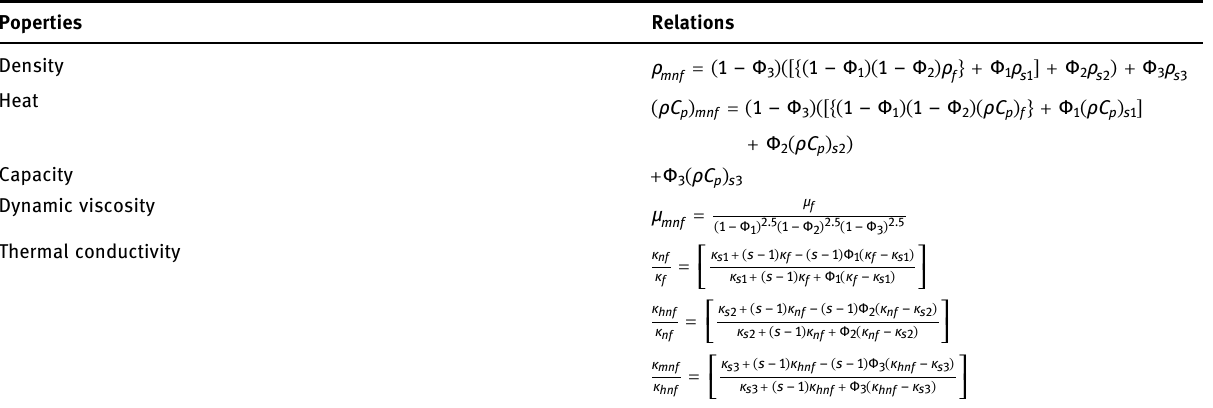
Table 2: MNF relations [ 29, 30,54 ]